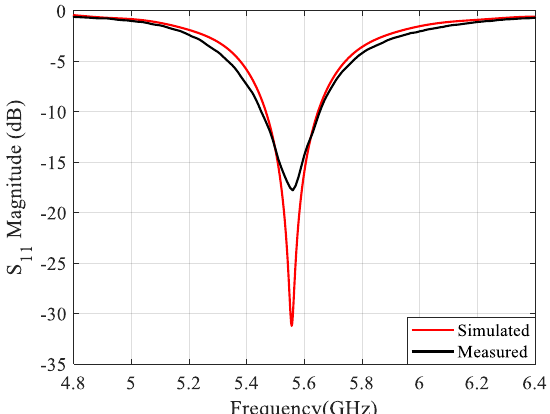
Figure 3. Microstrip antenna element reflection coefficient magnitude, simulated and measured.